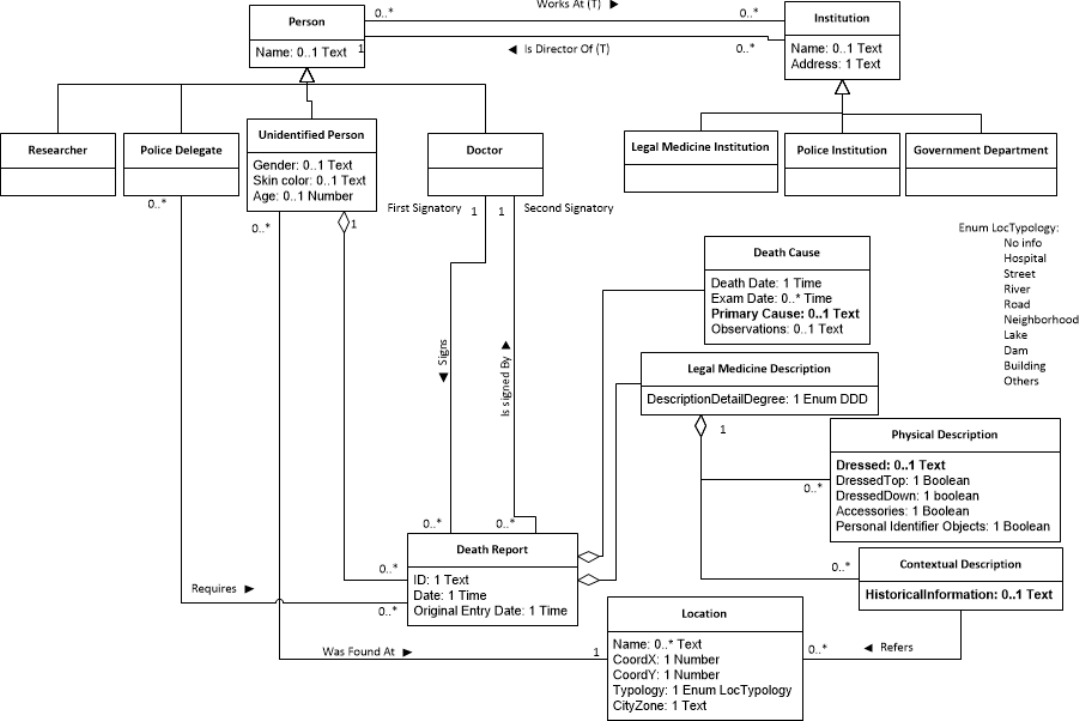
Figure 2. Conceptual model representing the major concepts, properties, and relationships that are mentioned in the corpus.